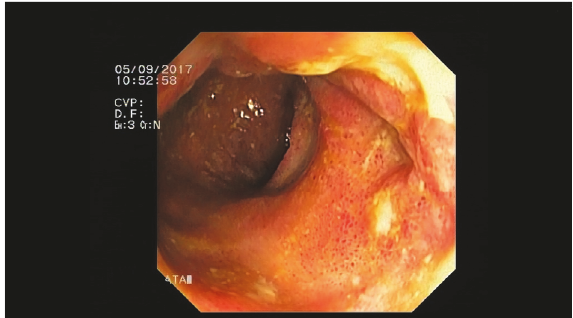
Figure 3: Representative endoscopy image of rectum and ileorectal anastomosis with swelling changes, congestion, and numerous aft- like loss of mucous